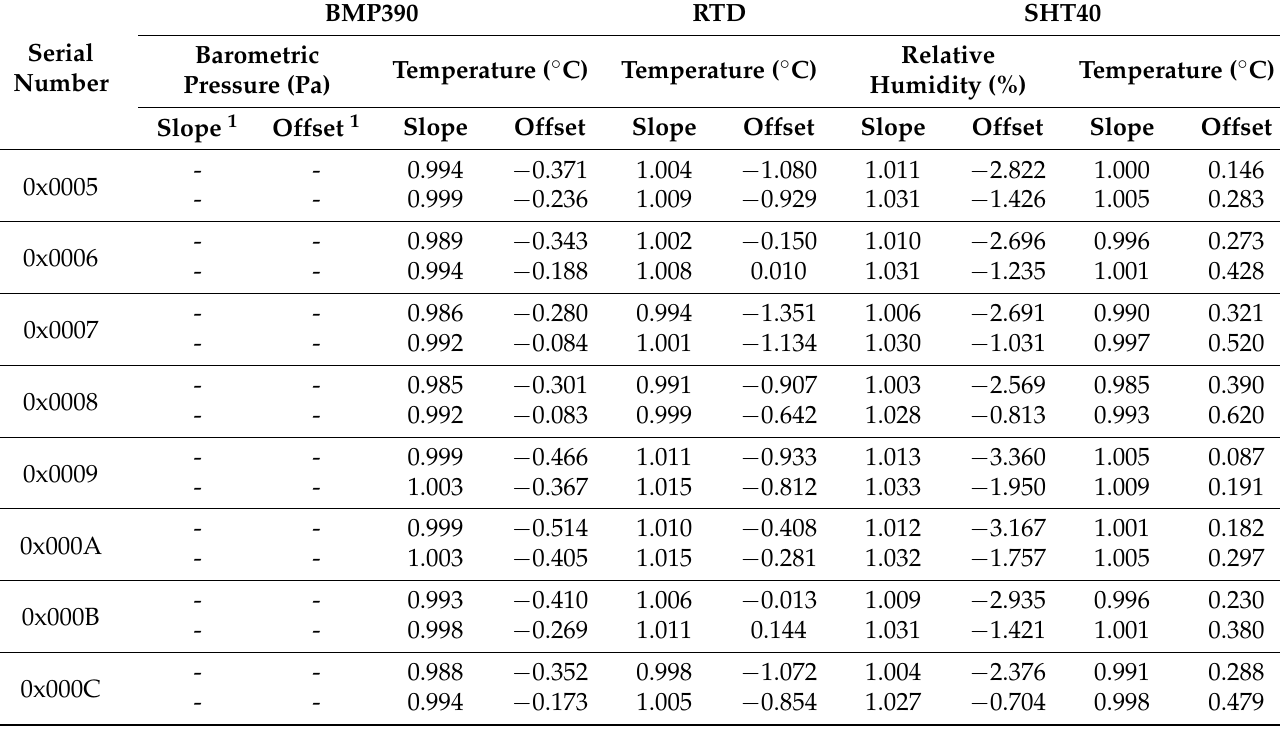
Table 7. Lower and upper bounds of the 95% confidence interval for calibration